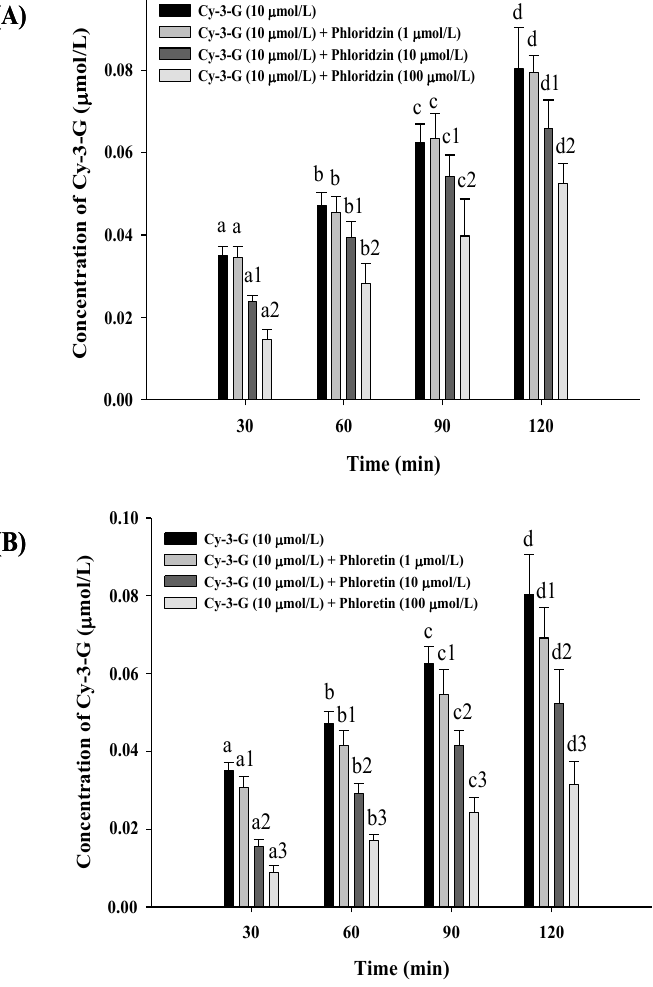
Figure 2. Effects of phloridzin and phloretin on Cy-3-G absorption. The cell monolayer was treated with phloridzin ( A ) or phloretin ( B ) for 0.5 h before the assays were carried out. Values without a common letter differ, p <